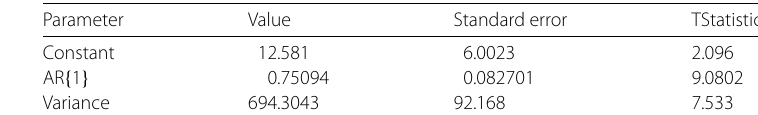
Table 2 Model estimation for deaths in Africa